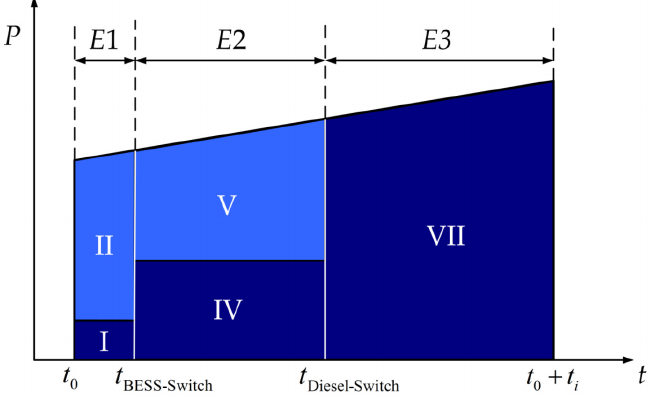
Figure 13. Compensated energy shortage ( ACR = 1).